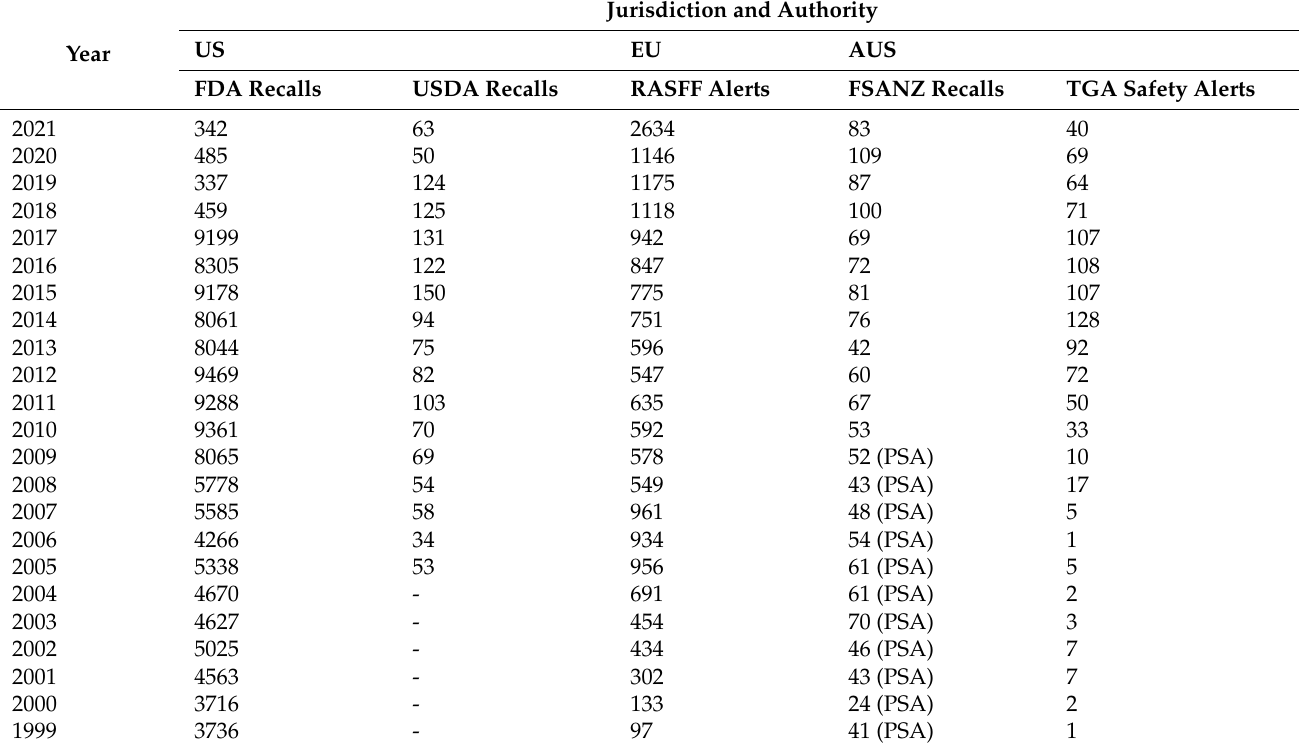
Table 3. Data on food safety alerts /recalls collected from respective authorities: USA- FDA, United States Department of Agriculture (USDA), EU- Rapid Alert System for Food and Feed (RASFF) and AUS- FSANZ, TGA and Product Safety Australia (PSA) from years 1999 to 2021